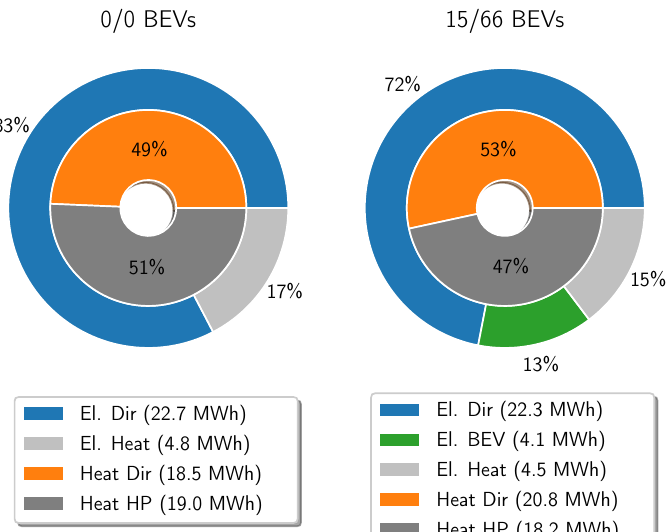
Figure 8. Energy-saving potential through further use of waste heat and influence of additional charging of BEVs. The outer ring shows how the electrical energy fed out from the FCEVs is used: the blue portion shows the electrical energy consumed directly, the light grey portion shows the energy consumed by the heat pump, and the green piece shows the energy used to charge the BEVs. The inner-circle diagram shows where the heat energy needed for hot water production and heating comes from: orange is the heat fed out of the FCEVs, and dark grey is the heat generated by the heat